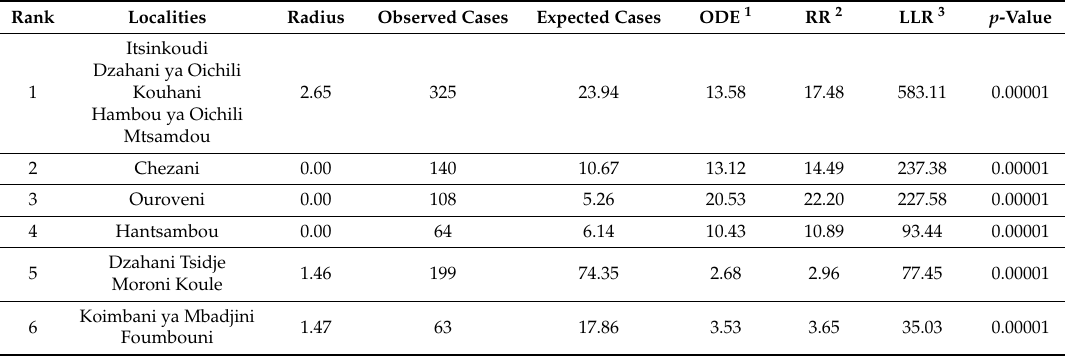
Figure 4. Location of malaria clusters and localities with significant Anselin Local Moran’s I index in Grande Comore in 2016. Table 1. Clusters determined by Kulldorff’s scanning method.